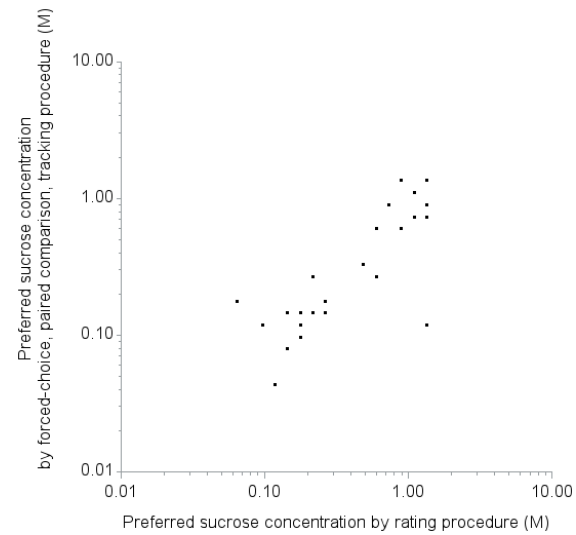
Figure 3. Comparison of the preferred sucrose concentrations measured by rating procedure and forced-choice, paired comparison, tracking procedure. Spearman correlation coefficient was 0.75 (95% CI: 0.51 to 0.88, p -value < 0.01).